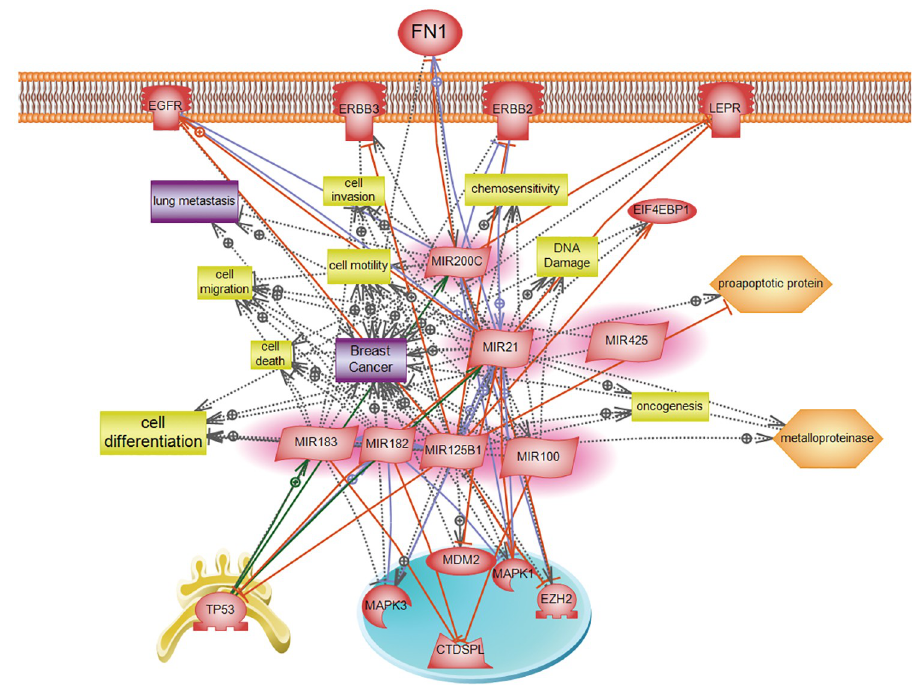
Fig 5. Pathway studio network analysis of the studied microRNA in breast cancer. A biological network was created using the Pathway Studio 9.0 program to visualize the role of different microRNA discussed in this manuscript in chosen breast cancer-related